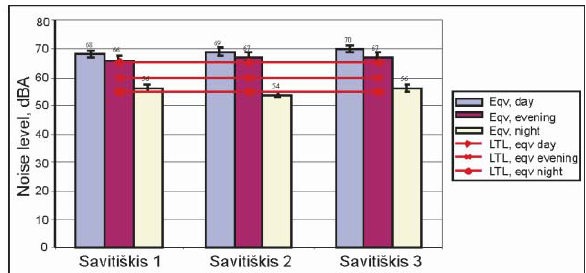
Fig. 12. Dynamics of equivalent noise levels in Savitiškis street within twenty four